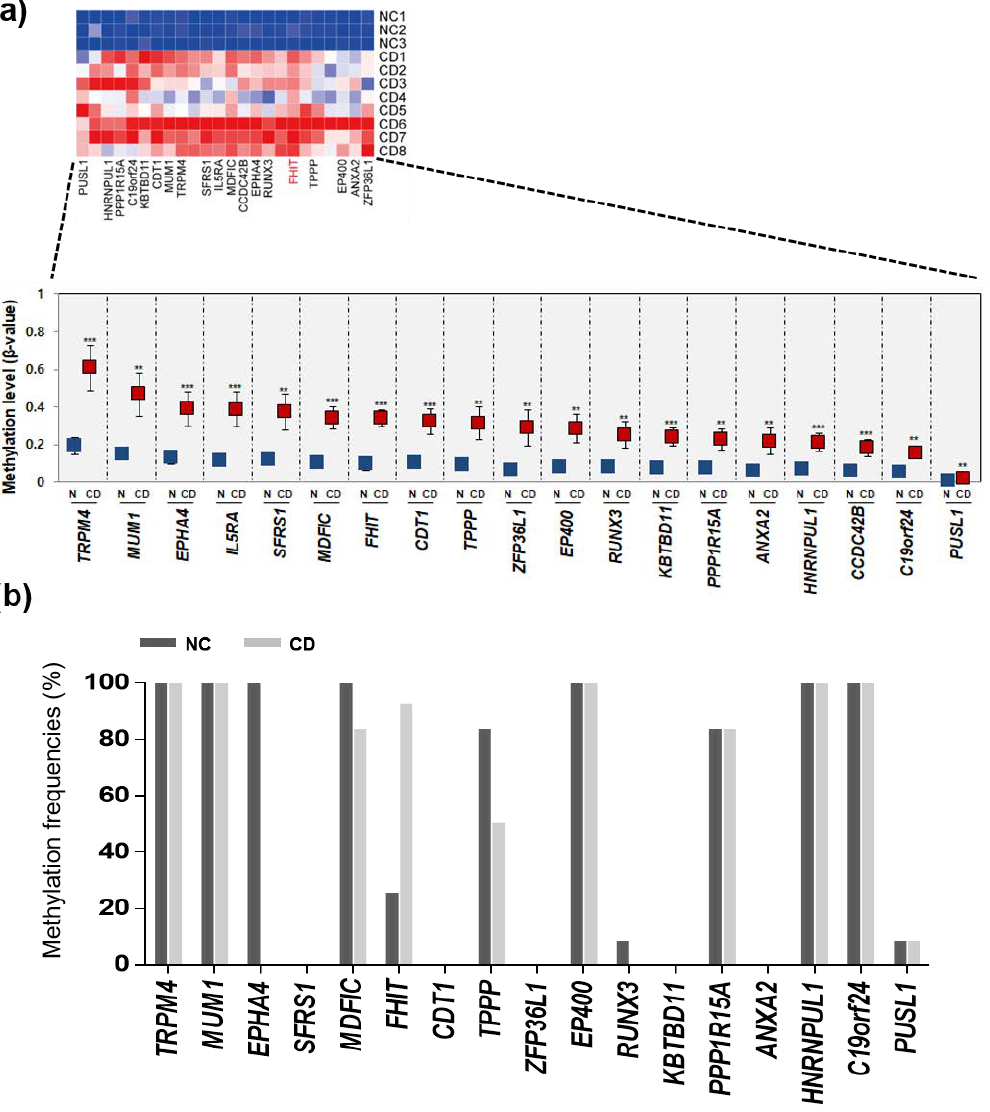
Figure 2. Hypermethylation pattern of candidate genes in patients with CD. ( a ) Heat map and hierarchical clustering dendrogram of 19 hypermethylated genes that exhibited > 2.5-fold increases in β -values in CD tissues compared to normal tissues. ( b ) Methylation frequencies of candidate genes in CD tissues ( n = 12) compared to normal tissues ( n = 12) determined by methylation-specific PCR